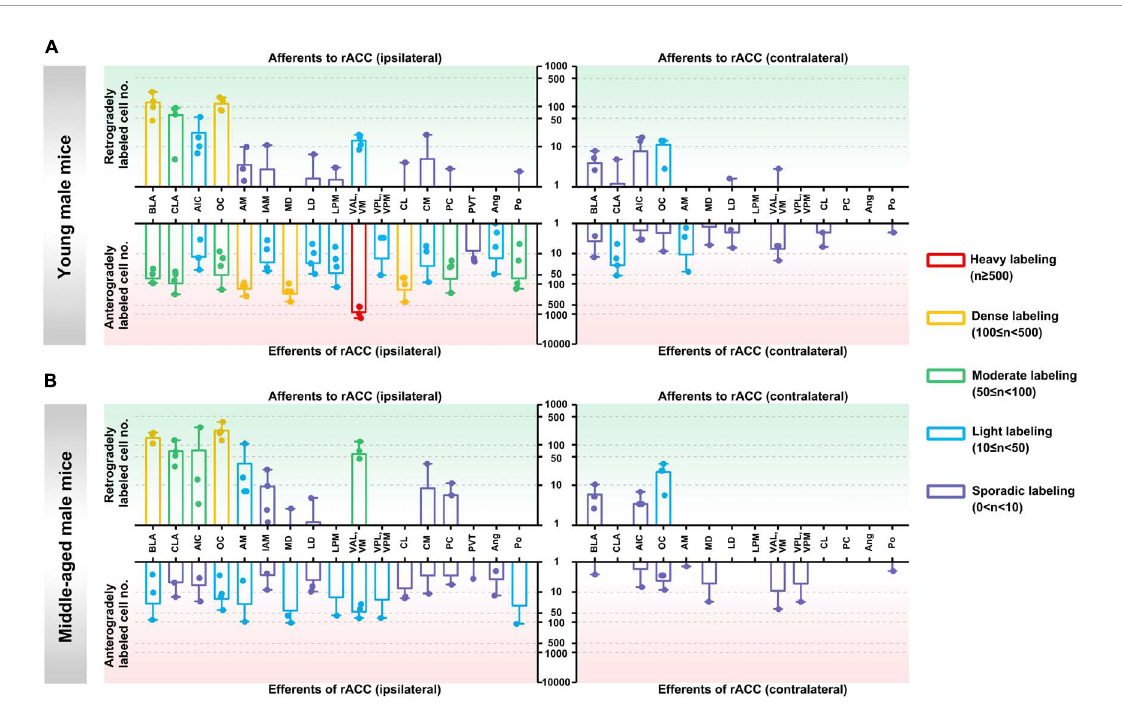
FIGURE2 Afferents and efferents of the rACC in young and middle-aged male mice. (A) The number of retrogradely and anterogradely labeled cells in different brain regions ipsilateral and contralateral to the injection site of the rACC was quantified in young male mice ( n = 3–4 animals, error bars represent s.e.m.). (B) The number of retrogradely and anterogradely labeled cells in different brain regions ipsilateral and contralateral to the injection site of rACC was quantified in middle-aged male mice ( n = 3–4 animals, error bars represent s.e.m.).